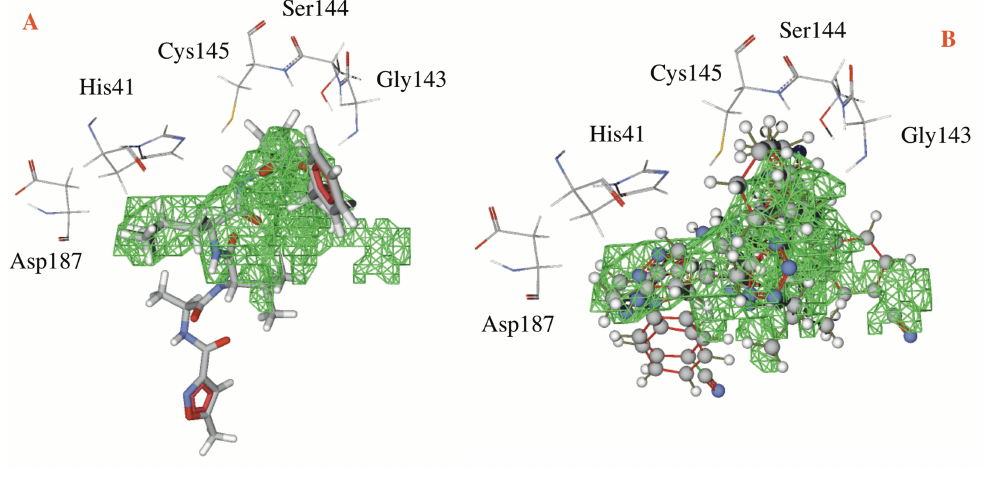
Figure 3 Catalytic site of the CoV-2-M Pro protein. (A) The co-crystalized ligand, and (B) the two best ligands interacting into the catalytic site of the Cov-2-M Pro protein.